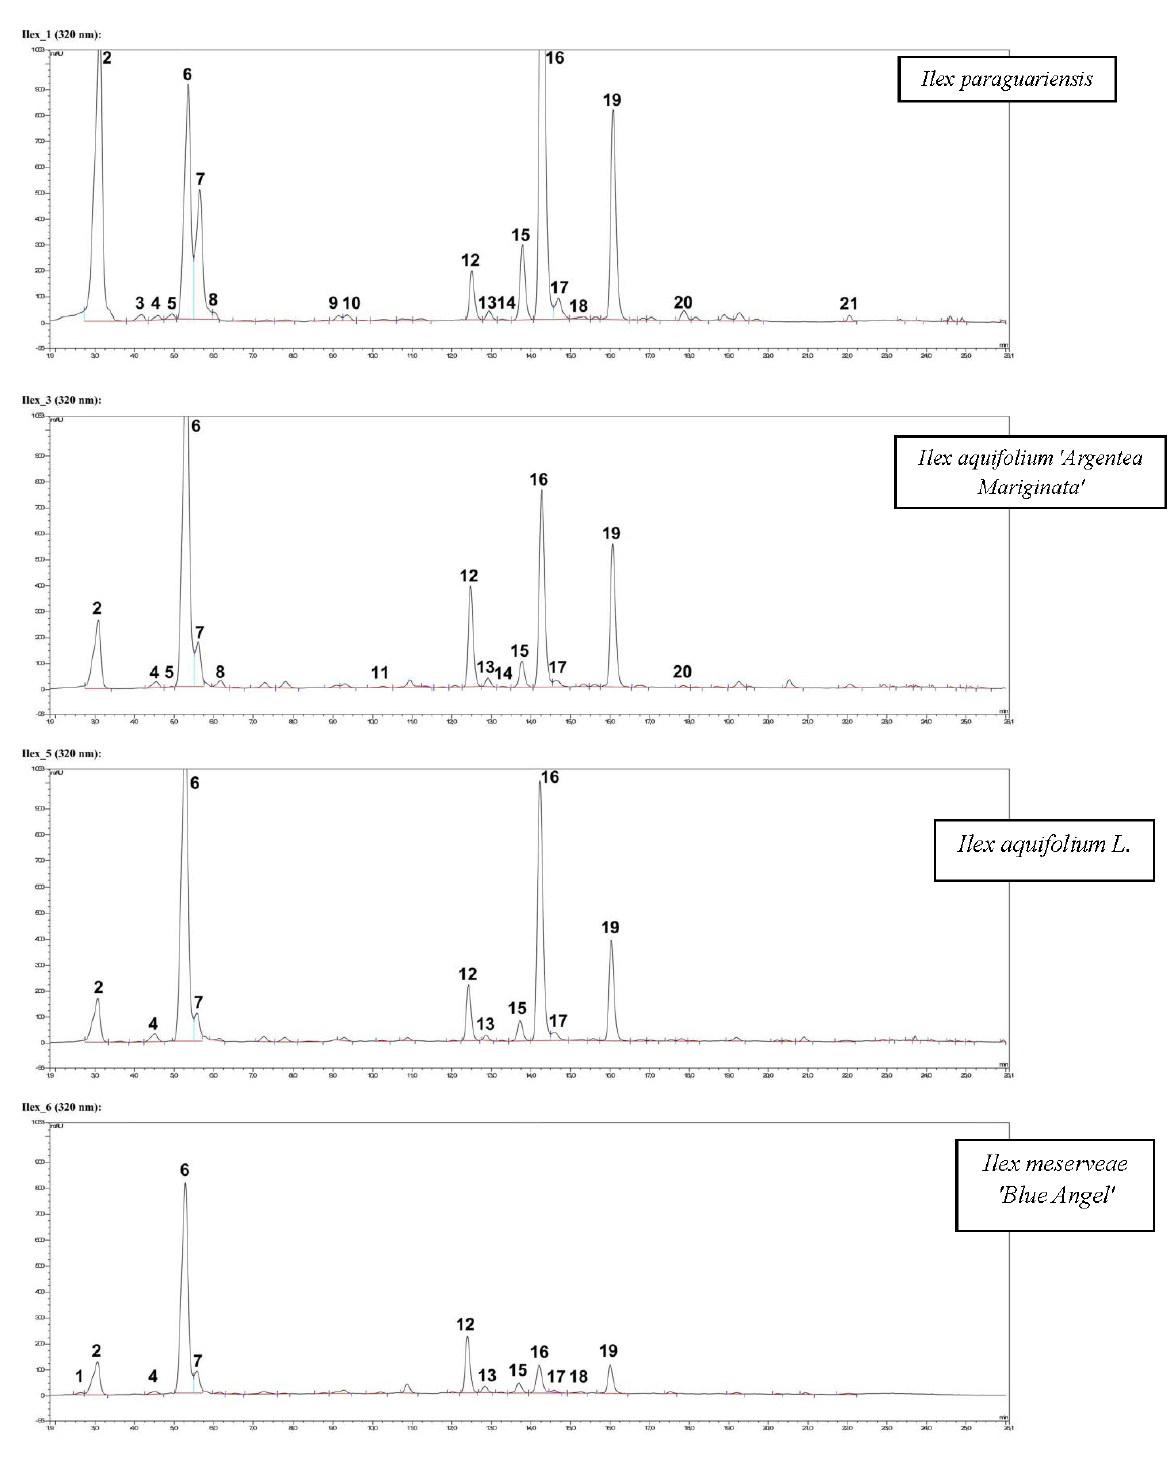
Figure 3: HPLC DAD chromatograms of Ilex sp. signal at 320